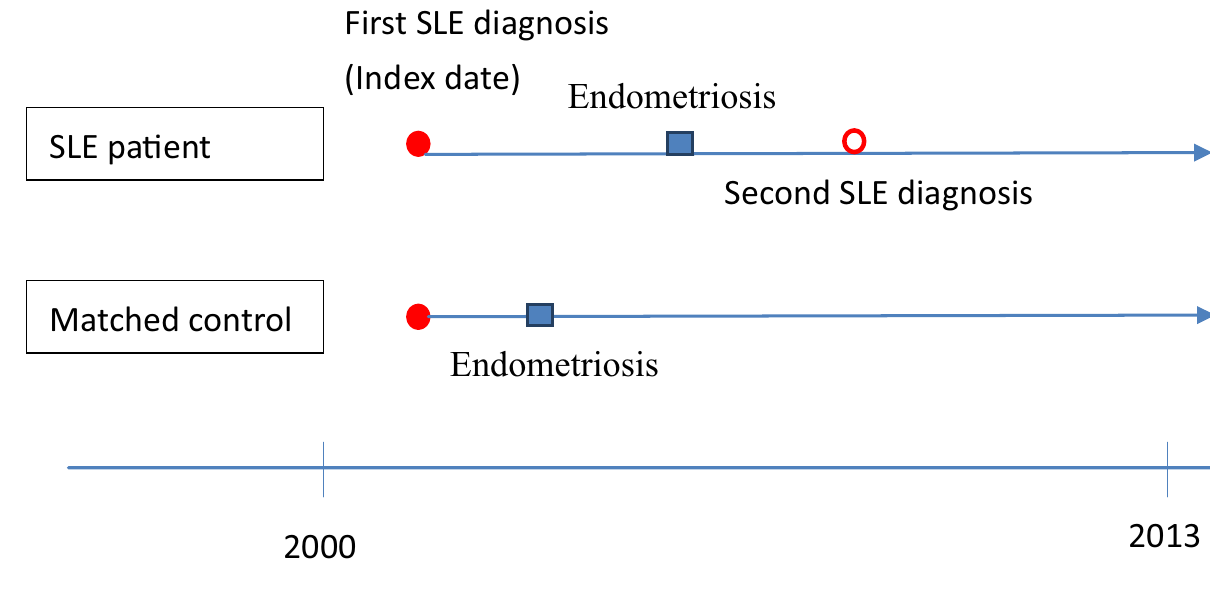
Figure 2. Diagram of follow-up from index date for SLE patients and matched